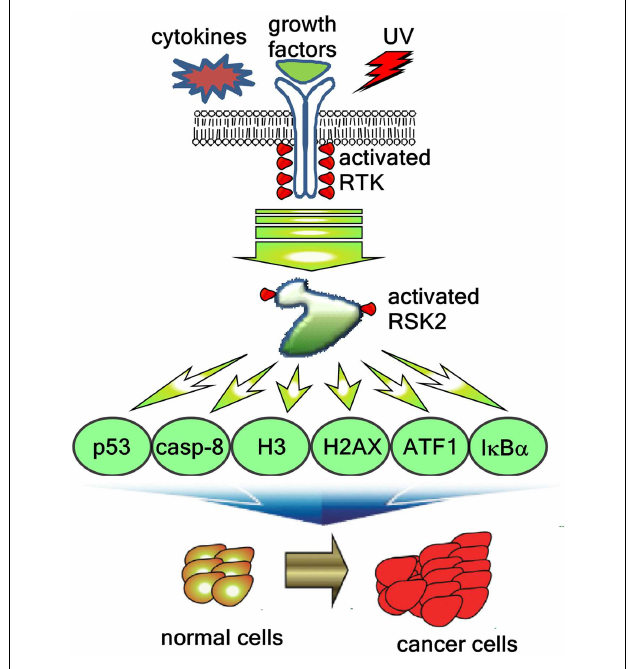
FIGURE 4 | RSK2-mediated signaling pathways regulate cancer development . Extracellular stimuli including cytokines, growth factors, and environmental stresses induces the RSK2 phosphorylation through receptor tyrosine kinase (RTK), Ras, Raf, MEK, and ERK, resulting in activation of RSK2.The activated RSK2 phosphorylates the downstream target proteins including transcription factors such as ATF1 and p53, epigenetic factors such as histone H3 and histone 2AX, and signaling molecules such as caspase-8 and I κ B α , resulting in the cell proliferation and transformation, and cancer